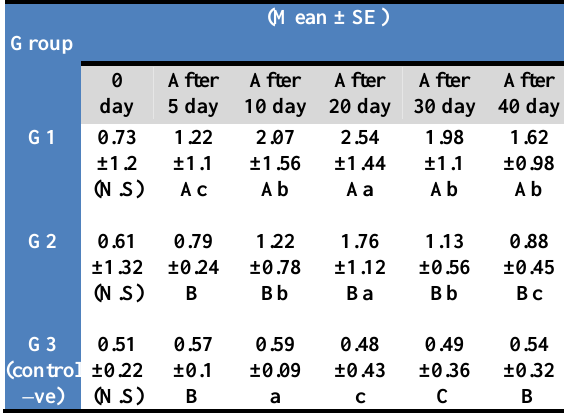
The different capital letters in column refer to significant differences (P≤0.05) among groups and different small letters in row refer to significant differences (P≤0.05) among period. (N.S)= non